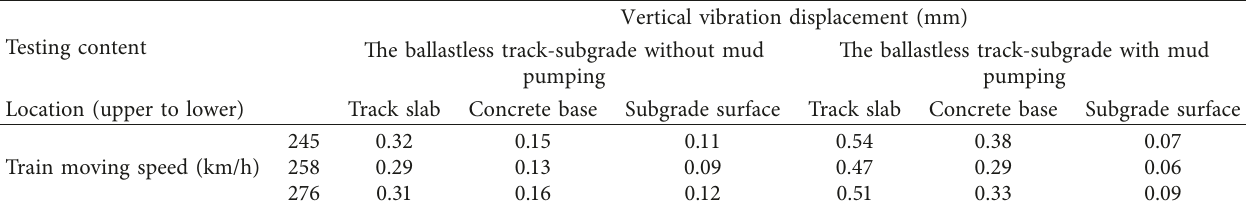
Table 5: The vertical vibration displacement of the ballastless track-subgrade with mud pumping.